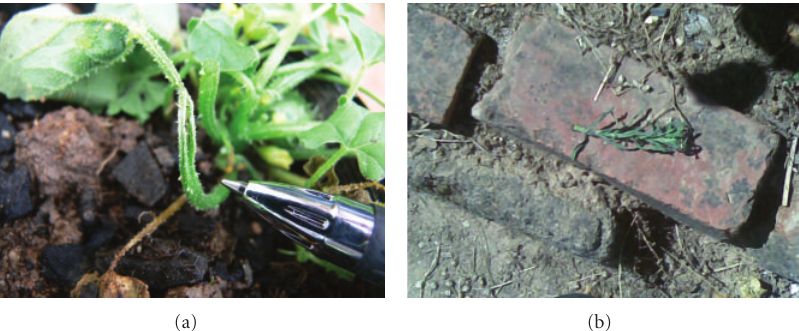
Figure 4: (a) Ruptured stem of a paddy melon plant and (b) a severed stem of fleabane plant; both occurred after only a few seconds of microwave treatment using the 86mm by 20mm aperture horn antenna. Table 1: Mean survival percentages for fleabane and paddy melon during microwave treatment experiments (unpublished data). Species Antenna design